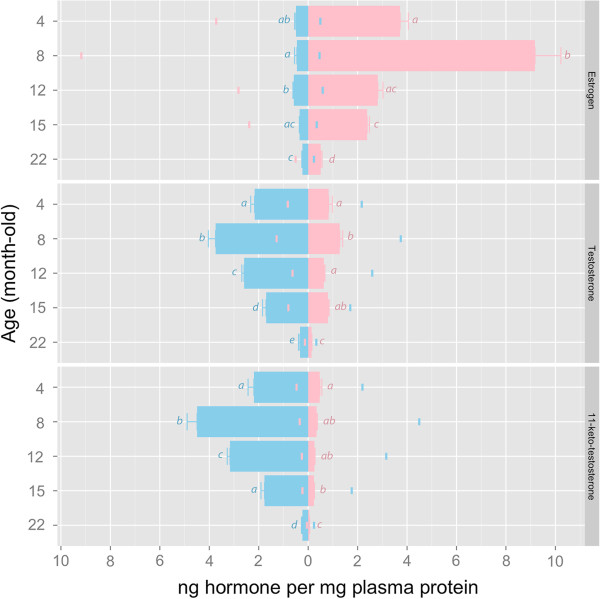
Change of plasma sex hormones level in male (blue) and female (pink) O. latipes during aging (top: estrogen; middle: testosterone; bottom: 11-keto-testosterone). Normalized hormone levels are denoted by the bar length and the colored mark on the opposite side of the origin. Error bars are standard error of mean (SEM). Bars annotated with different letters are significantly different. Statistical significant difference between the two sexes was detected for all three sex hormones at all age groups (all FDR-adjusted p < 0.05).